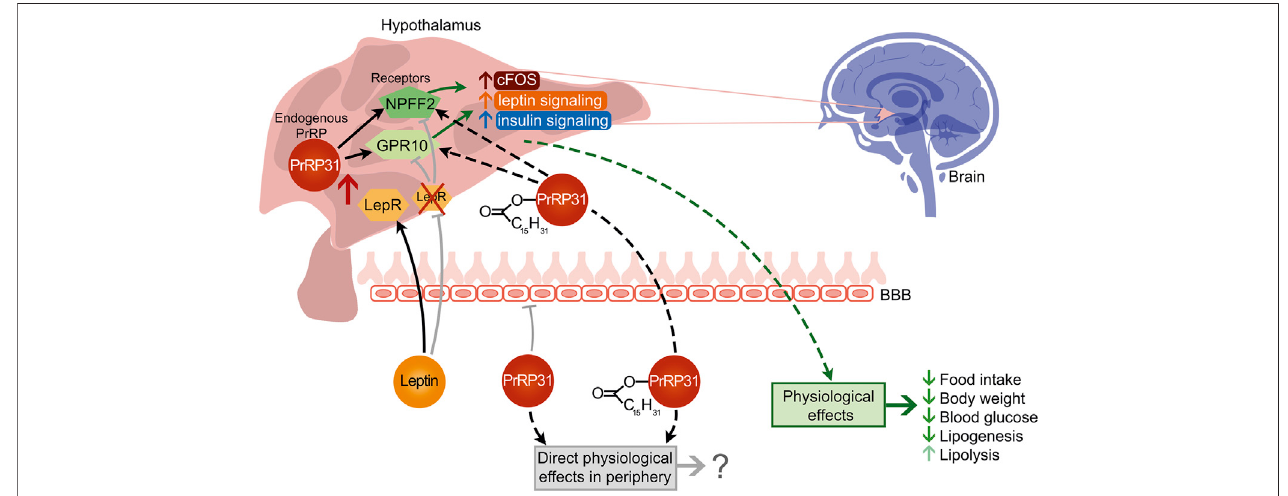
FIGURE 5 | Proposed peripheral and central action of natural PrRP31 and its palmitoylated analog.